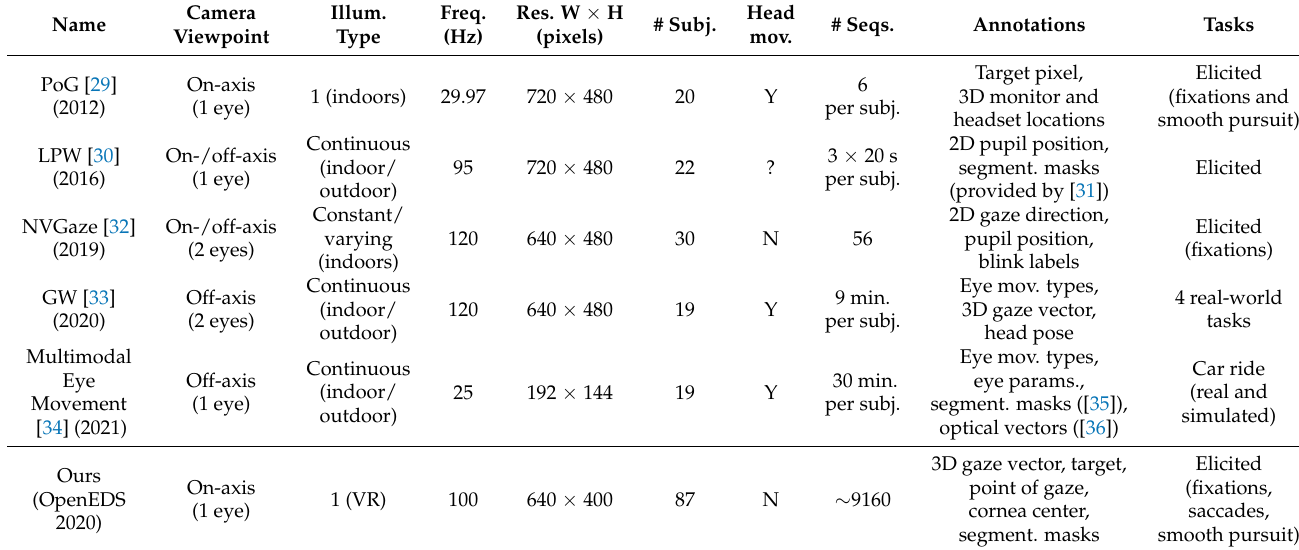
Table 1. Summary of existing, publicly available eye tracking datasets containing sequences of real eye images obtained using IR cameras. “Illum.”, illumination; “Res. WxH”, image resolution width × height; “Freq.”, sampling rate; “# Subj.”, number of subjects; “Head mov.”, head movement allowed during recordings; “#. Seqs.”, number of